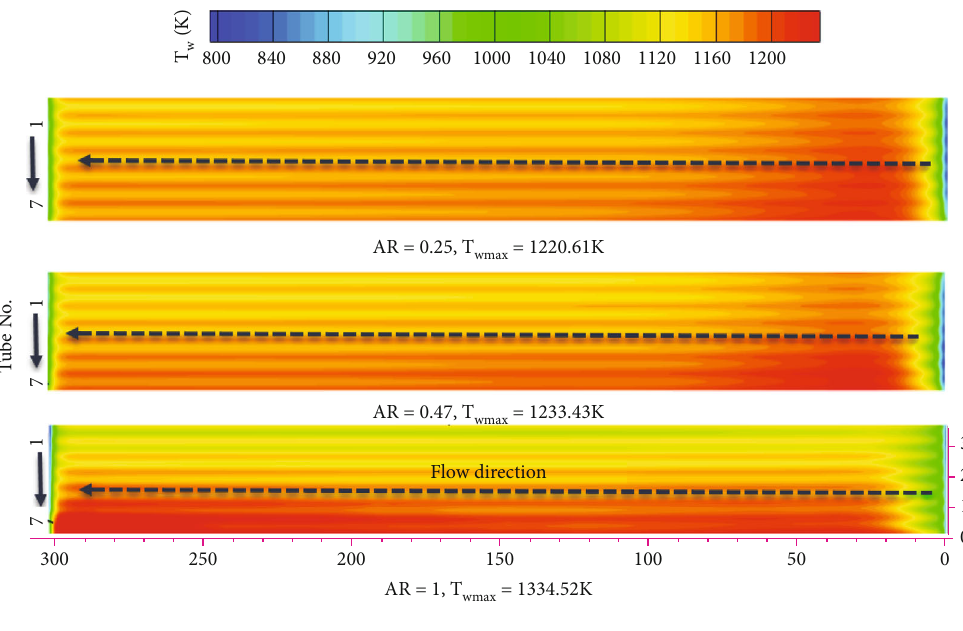
Figure 6: The wall temperature contours with di ff erent AR values.